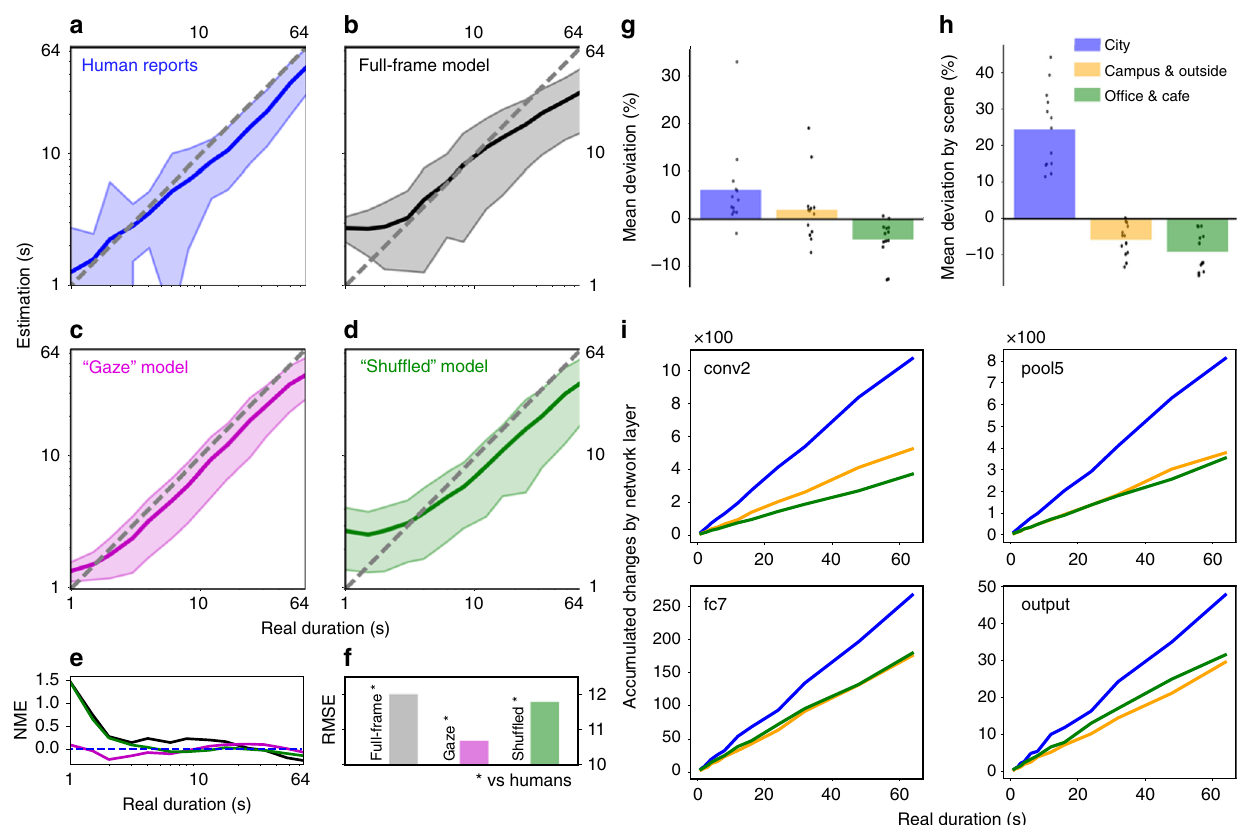
Fig. 3 Human and model duration estimation and its modulation by scene type. a Human duration estimates by duration of presented video between 1 and 64 s (log-log scale). b – d as for a but for model versions Full frame, “ Gaze ” and “ Shuf fl ed ” . The data in each plot a – d are based on the same set of 4251 video presentations, reported on by human participants a or estimated by different model versions b – d . Shaded areas in a – d show ±1 standard deviation of the mean. Human reports in a show typical qualities of human temporal estimation with overestimation of short and underestimation of long durations. b Model estimates when input the full video frame replicate similar qualitative properties, but estimation was poorer than humans. c Model estimates when the input was constrained to approximate human visual-spatial attention, based on human gaze data, very closely approximated human reports made on the same videos. When the gaze contingency was “ Shuf fl ed ” such that the gaze direction was applied to a different video than that from which it was obtained d , performance decreased. e Comparison of normalised mean error (NME) in estimations for models and human estimates (normalised by physical duration, across the presented durations). f Comparison of the root mean squared error (RMSE) of model estimates compared to the human data. The “ Gaze ” model is most closely matched (Full frame: 11.99, “ Gaze ” : 10.71, “ Shuf fl ed ” : 11.79). g Mean deviation of duration estimates relative to mean estimate by scene type for human participants (mean shown in a ; City: 6.20 mean (1040 trials), Campus & outside: 2.01 mean (1170 trials), Of fi ce & cafe: